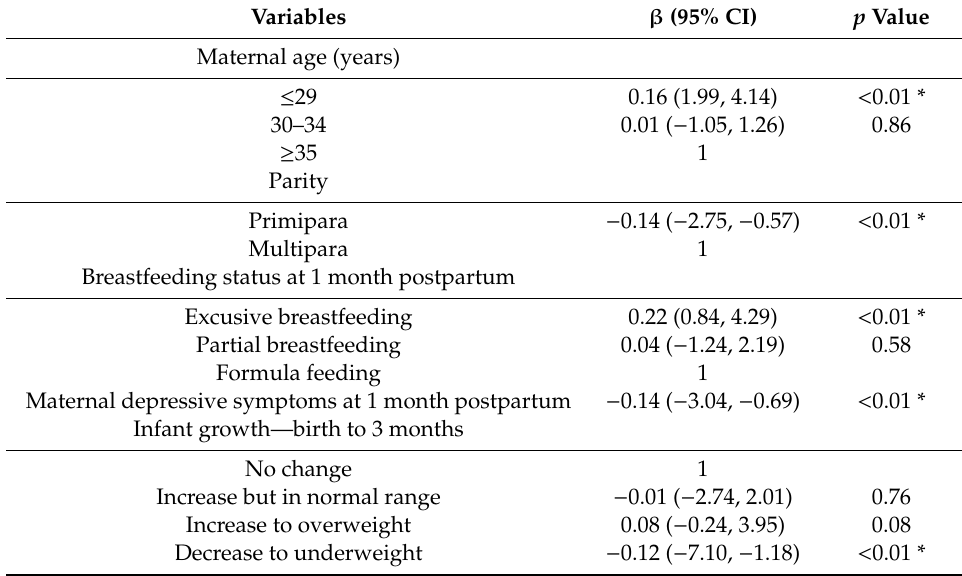
Table 5. Multiple linear regression model for responsive feeding at 3 months